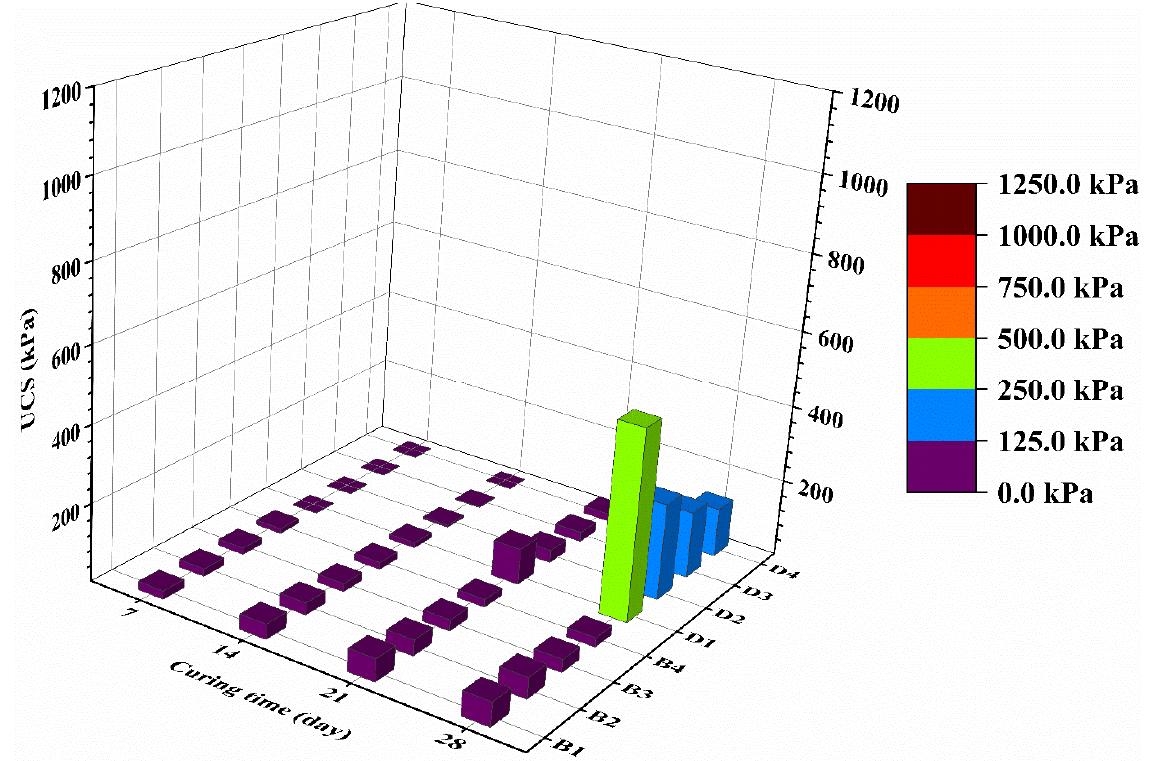
Figure 3. UCS of solidified samples at the same binder content and different water content.